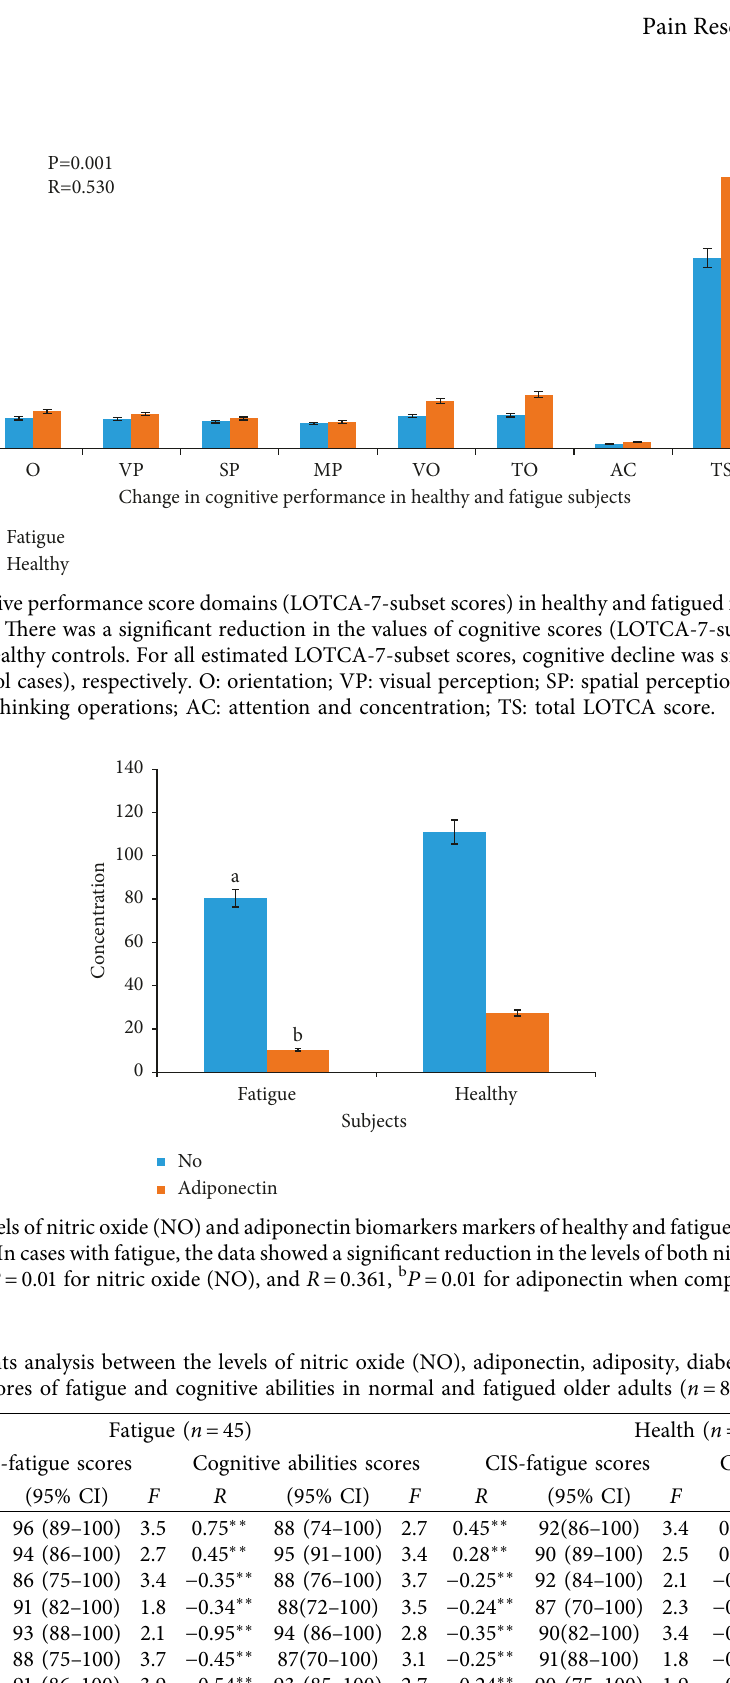
Datapresentedasacoefficient( R );